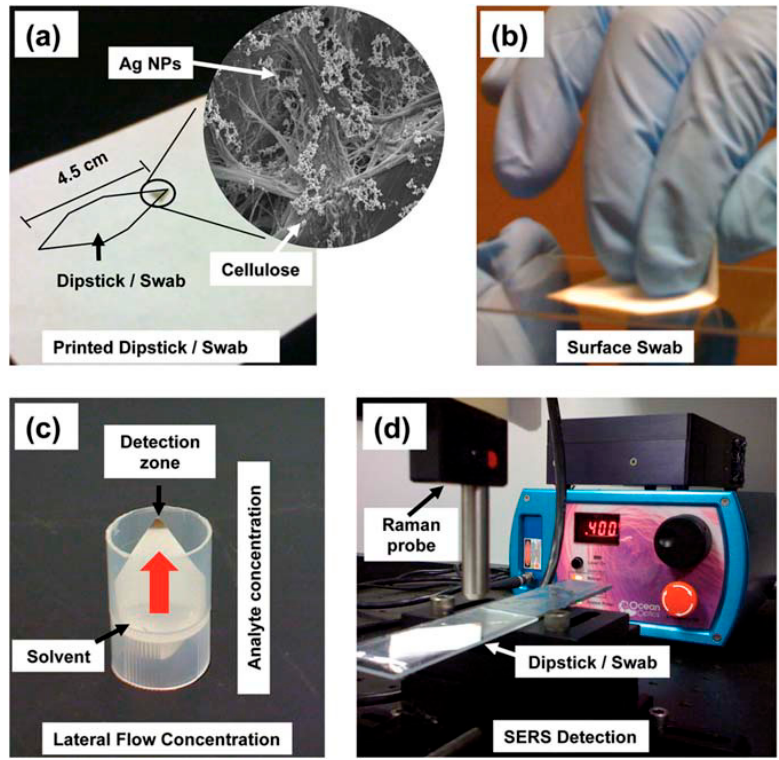
Figure 24. ( a ) Dipstick/swab paper substrate: The SERS active region is printed in the top vertex; the inset is a SEM image showing the silver nanoparticles at the surface of cellulose fibers. ( b ) Substrate used as a swab to collect the analyte. ( c ) The swab/dipstick impregnated with the analyte is immersed in a solvent. The solvent flows through the paper substrate, wicked by capillary forces, and concentrates the analyte in the SERS active region. ( d ) Instrument used for collecting SERS spectra. Reproduced with permission from Yu et al. [393]. Copyright (2013), the Royal Society of Chemistry.